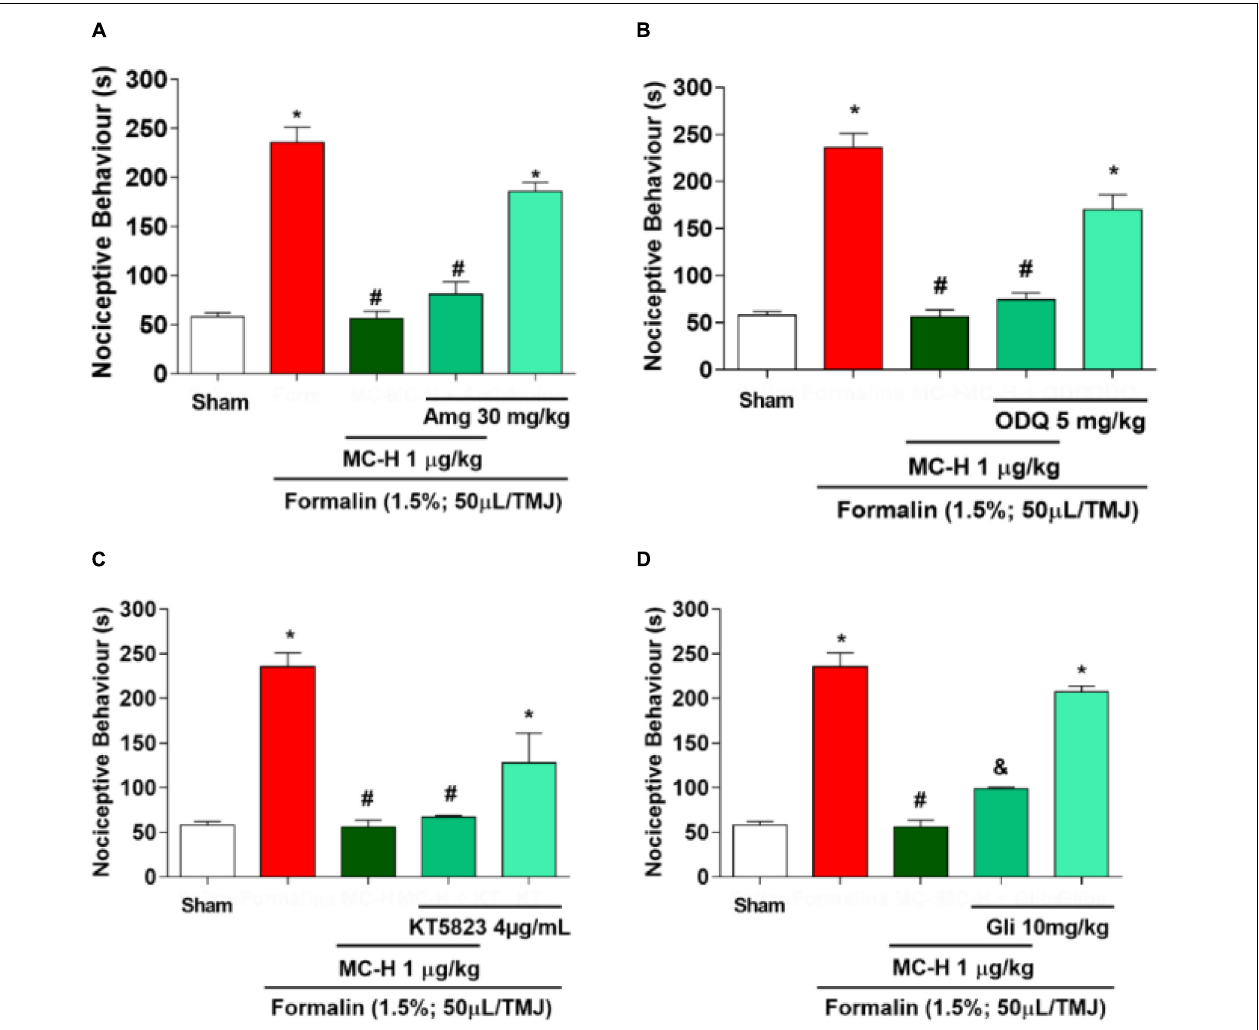
FIGURE 5 | The role of NO/cGMP/PKG/K + ATP signaling pathway in the MC-H-induced antinociception. Rats received the NO/cGMP/PKG/K + ATP pathway inhibitors 30 minutes before MC-H (1 µ g/kg; po) treatment. The nociceptive behavior was evaluated 1 h after the MC-H administration. (A) Aminoguanidine - Amg (30 mg/kg; ip ), (B) ODQ (5 mg/kg; sc ) or (C) KT5823 (4 µ g/mL; sc ) did not modify the nociceptive response of MC-H ( p < 0.05: ANOVA, Tukey’s test). However, (D) the pre-treatment with glibenclamide - Gli (10 mg/kg; ip ) increased the nociceptive behavior ( p < 0.05: ANOVA, Games-Howell test). The symbols ( ∗ ), (#), and (&) represent statistically significant differences compared with saline, formalin, and MC-H groups,